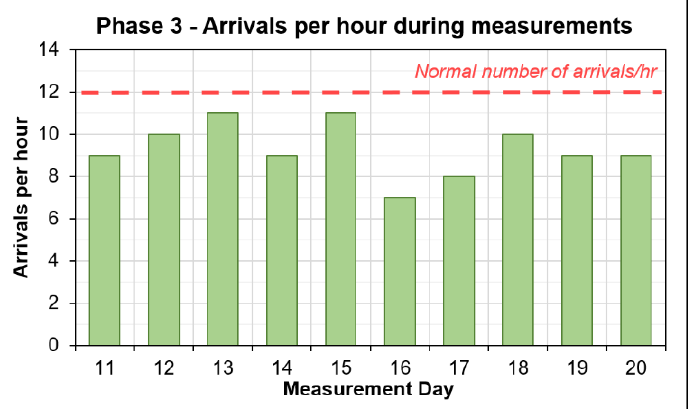
Figure 3. Comparison of hourly arrivals to those before the COVID-19 pandemic.